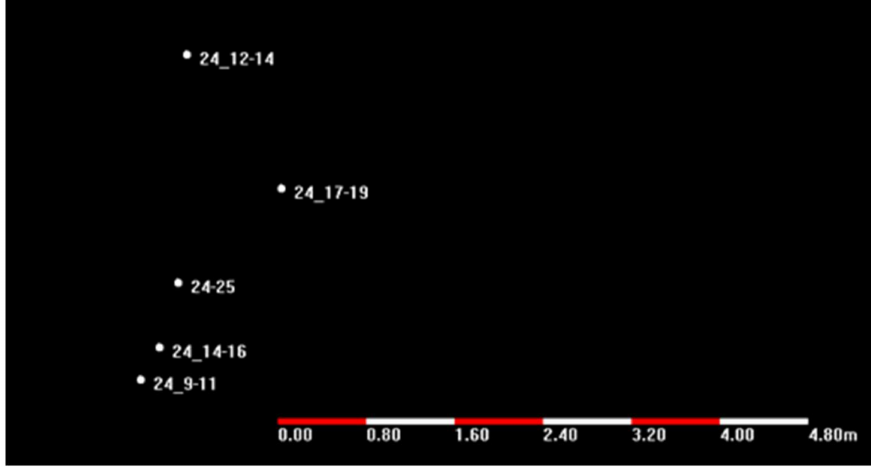
Figure 6. Single-point positioning relative